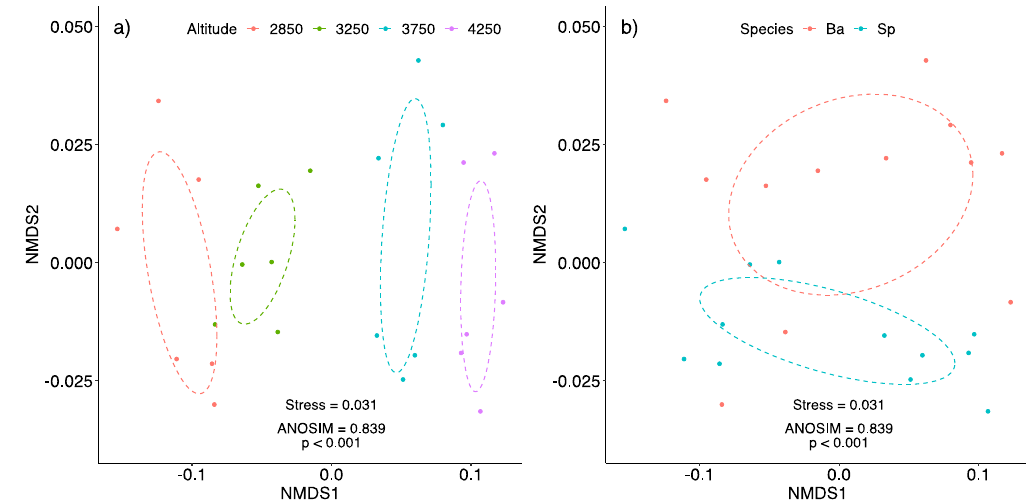
Figure 2. Non-Metric Multidimensional Scaling (NMDS) with 95% confidence ellipse obtained from the plant compounds analyzed (proline, protein, sugar, ABA, IAA) at different altitudes among ( a ) sampling sites and ( b ) species. The analyzed altitudes differed significantly in relation to the analyzed plant compounds, differently from plant species.